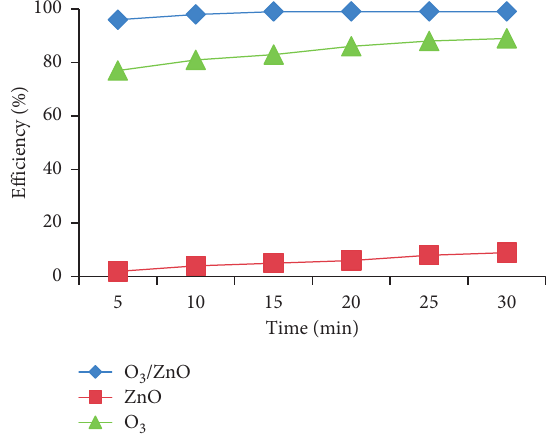
Figure 3: TMP removal by different treatment processes (ZnO � 500mg/L).